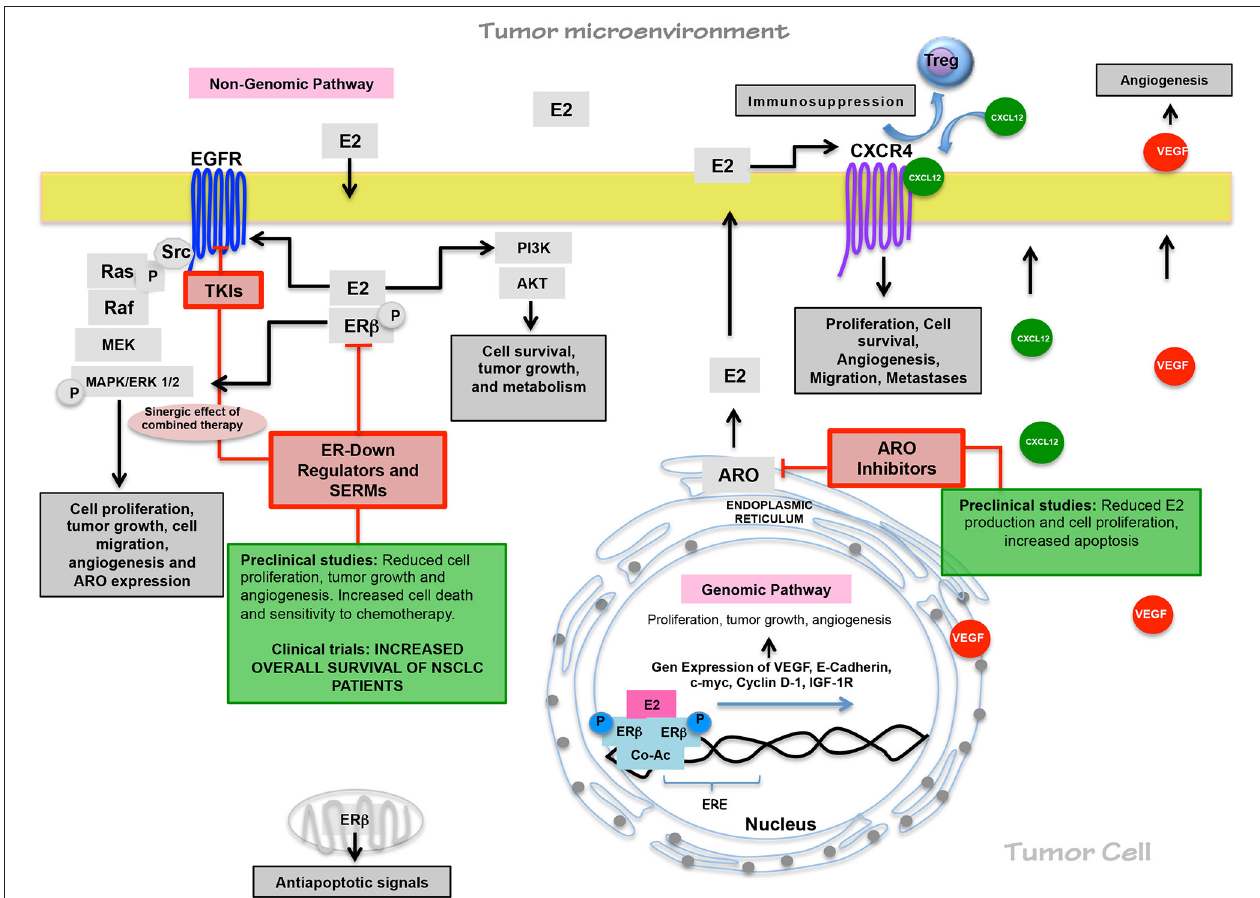
FIGURE 1 | Estrogen pathway in lung carcinogenesis and its relevance on therapy. Through non-genomic and genomic pathways, estrogen promotes cell proliferation, tumor growth, angiogenesis, cell migration, immunosuppressive responses, and tumor progression since tumor cells overexpressed ER β . ARO expression maintains elevated E2 levels. The functional relationship between EGFR/EGF and E2/ER pathways sustain the E2 production through ARO expression and the EGFR activation in EGF absence. Preclinical studies have shown antiestrogen treatment efficacy, and in clinical trials, antiestrogen drugs have improved the clinical benefits of TKI and